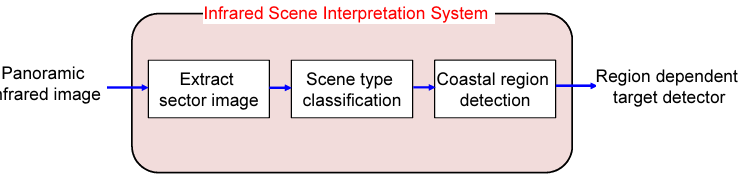
Figure 3. Proposed infrared scene interpretation